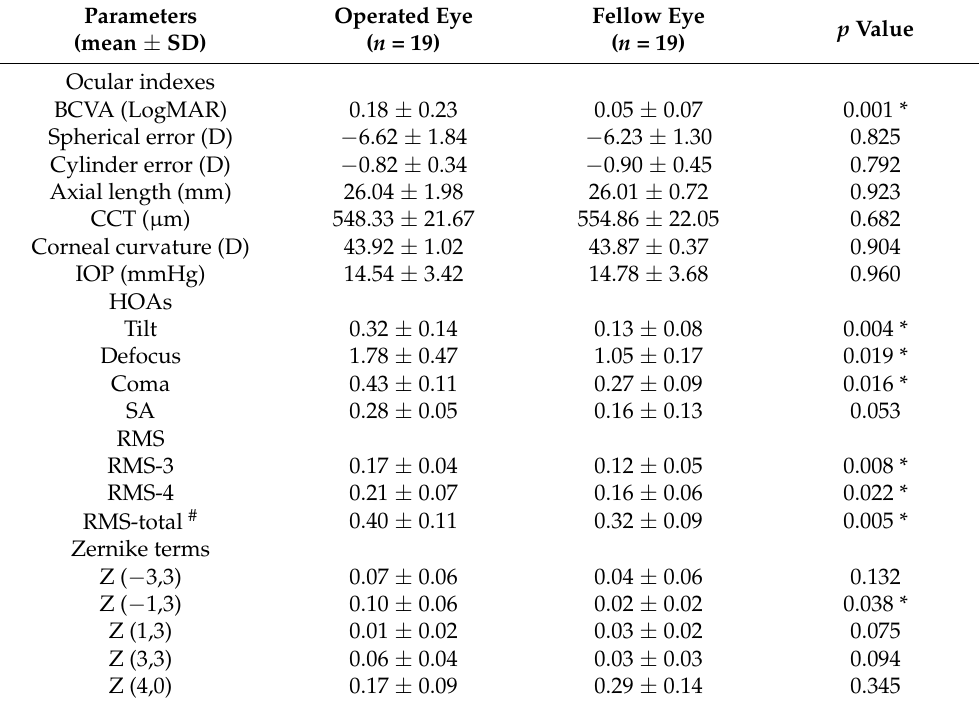
Table 3. Ocular indexes and higher order aberration data between the operated and fellow